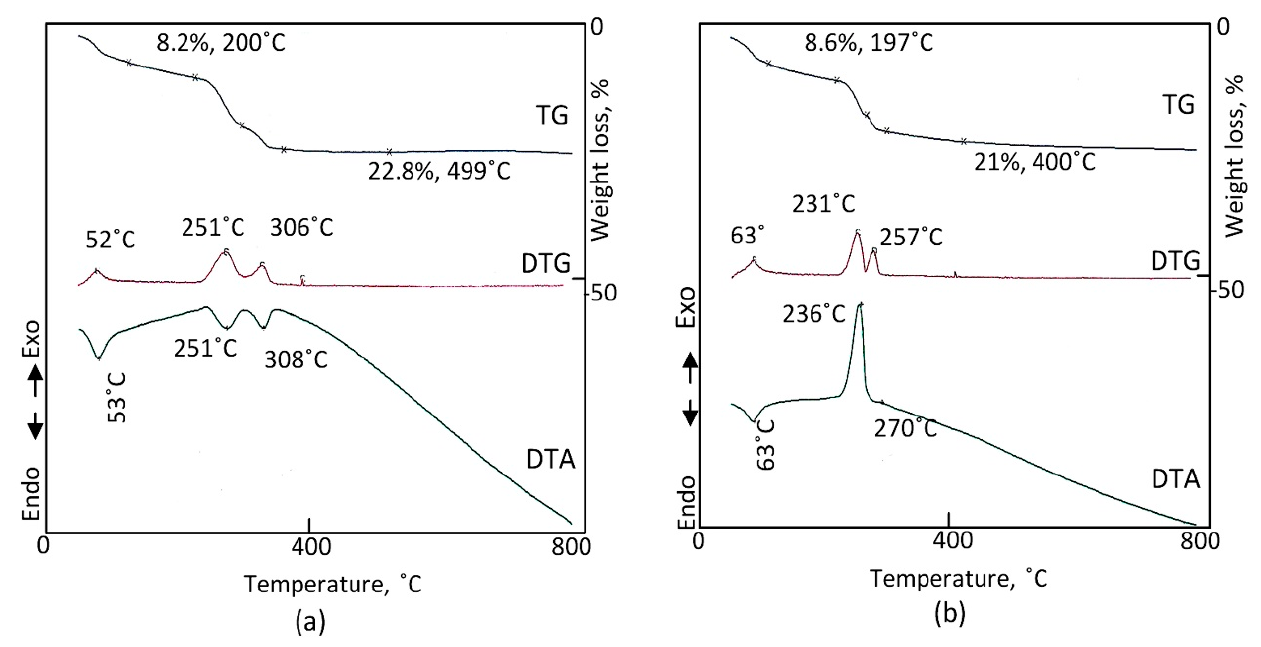
Figure 9. Thermal analyses of CSLDH-1 in presence of: ( a ) nitrogen gas and, ( b ) air. In the case of CSLDH-2, Figure 10a shows the thermal analyses in the presence of nitrogen gas. Three weight losses were observed in the TGA curve, indicating the existence of one kind of the interlayered anions agreeing with FTIR data. Figure 10a shows that 9 wt.% of surface water was lost at 99 ◦ C and 6.2 wt.% of the interlayered water was removed at 231 ◦ C [39]. In addition, 5.2 wt.% of nitrate anions were lost at 321 ◦ C. DTG and DTA confirmed the presence of one kind of anions through one peak at 263 ◦ C and 269 ◦ C, respectively. In presence of air, these three weight losses were clearly observed in Figure 10b through TG and DTG diagrams. These peaks were confirmed by three endothermic peaks in DTA curve at 57 ◦ C, 165 ◦ C and 247 ◦ C.